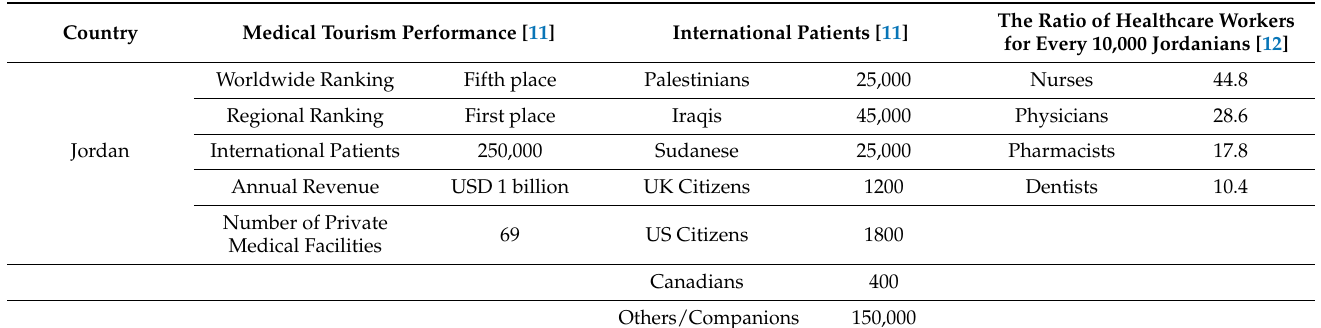
Table 2. Jordan Healthcare Statistics.